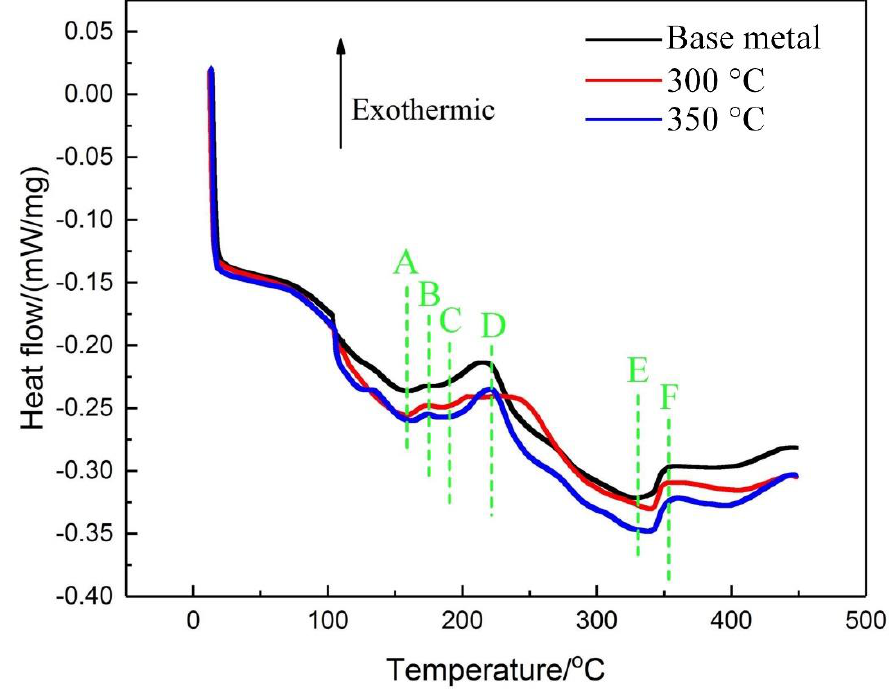
Figure 14. DSC curves of 7N01 aluminum alloy under different thermal cycling conditions.